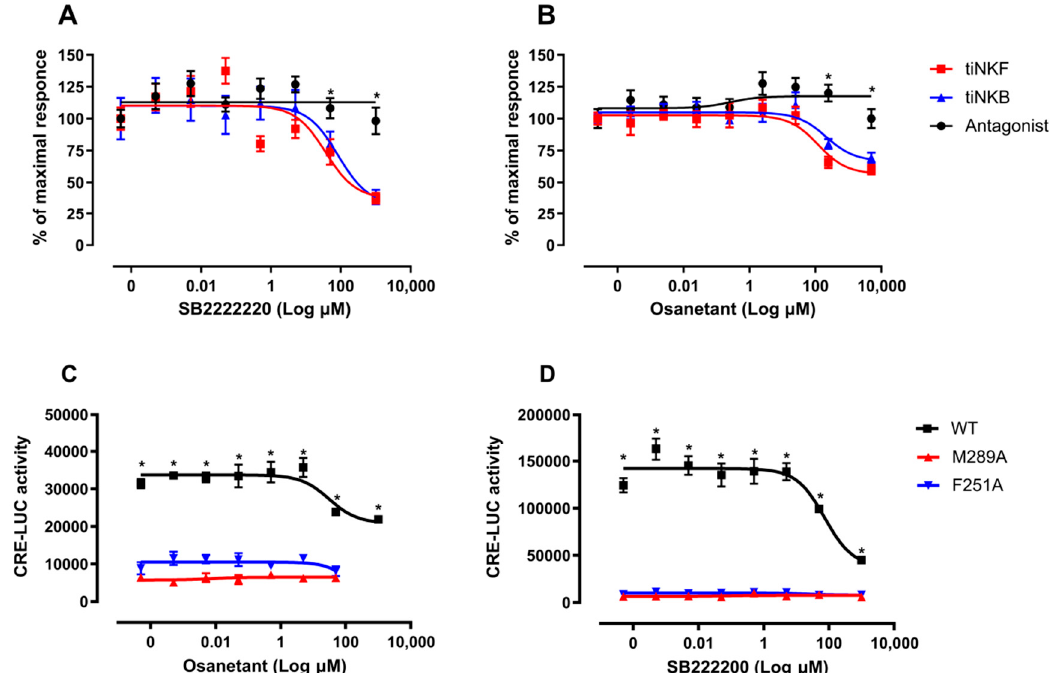
Figure 7. Luciferase assay (antagonists): COS7 cells were transfected with tiTac3Ra together with reporter plasmid CRE-luc. The cells were treated with various concentrations (0.001–1000 μ M) of NKB antagonists, SB - 22220 ( A ) and Osanetant ( B ) together with constant concentration (10 nM) of tiNKB or tiNKF. The data are expressed as percentage of maximal response and are from a single experiment, representative of a total of triplicates. Each point was determined in triplicate and is given as a mean ± SEM. COS7 cells were transfected with native tiTac3Ra and the mutant tiTac3Ra, M289A, and F251A, along with reporter plasmid CRE-luc. The cells were treated with various concentrations (0.001–1000 μ M) of NKB antagonists, SB - 222220 ( C ) and Osanetant ( D ) together with constant concentration (10 nM) of tiNKB. The data are expressed as % of maximal response and are from a single experiment, representative of a total of three such experiments. Each point was determined in triplicate and is given as a mean ± SEM. Asterisk ( * ) represent significant differences ( p < 0.05; One way ANOVA followed by Dunnett).